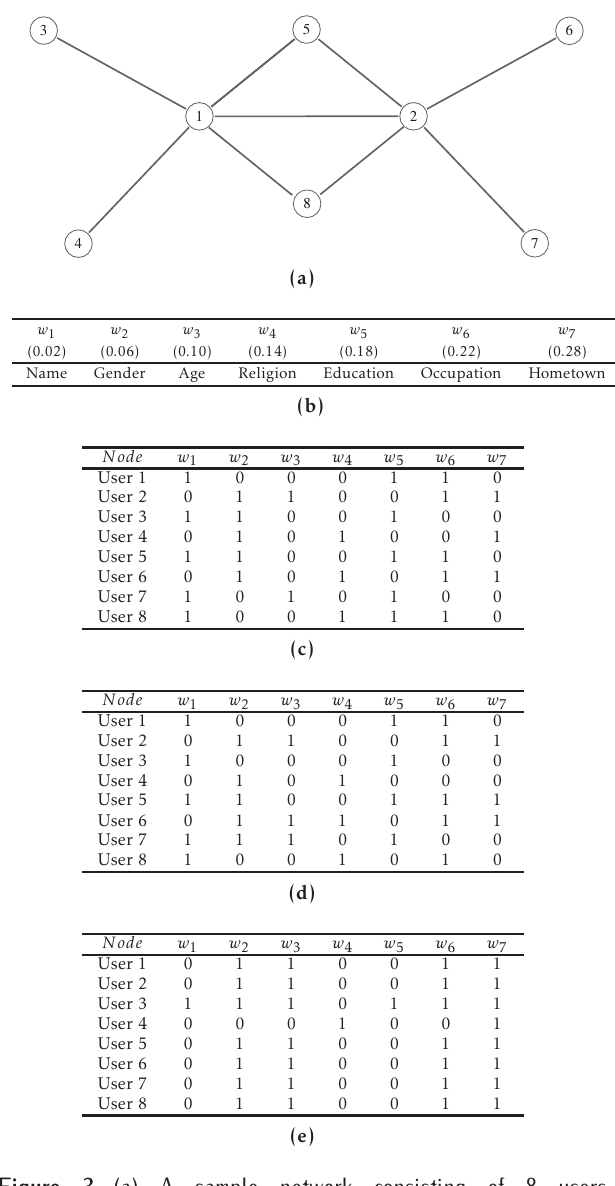
Figure 3. (a) A sample network consisting of 8 users connected to each other, (b) each user has a profile with 7 attributes with a weight vector ( w 1 , w 2 , ..., w 7 ) = (0 . 02 , 0 . 06 , 0 . 10 , 0 . 14 , 0 . 18 , 0 . 22 , 0 . 28) , (c) initial sign flags